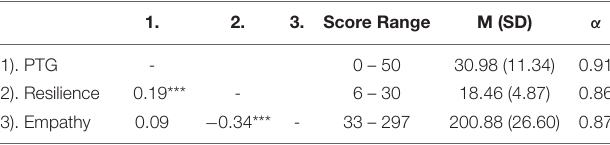
TABLE 1 | Correlations of PTG, resilience, and empathy.